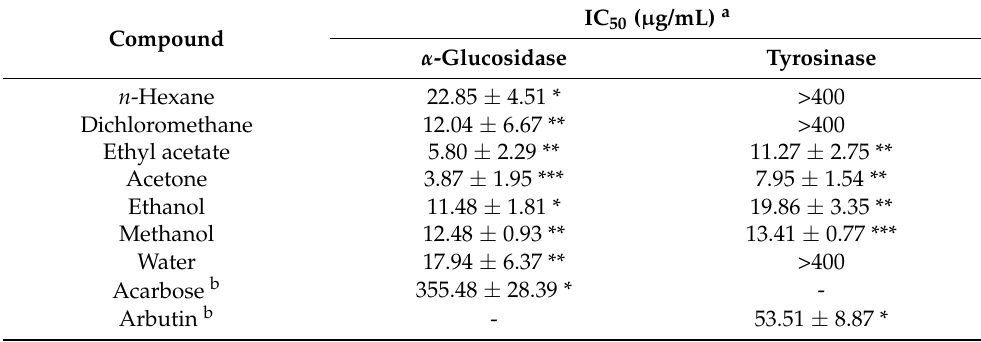
Table 3. α -Glucosidase and tyrosinase inhibitory activities of various solvent extracts. IC 50 ( µ g/mL) a Compound α -Glucosidase Tyrosinase n